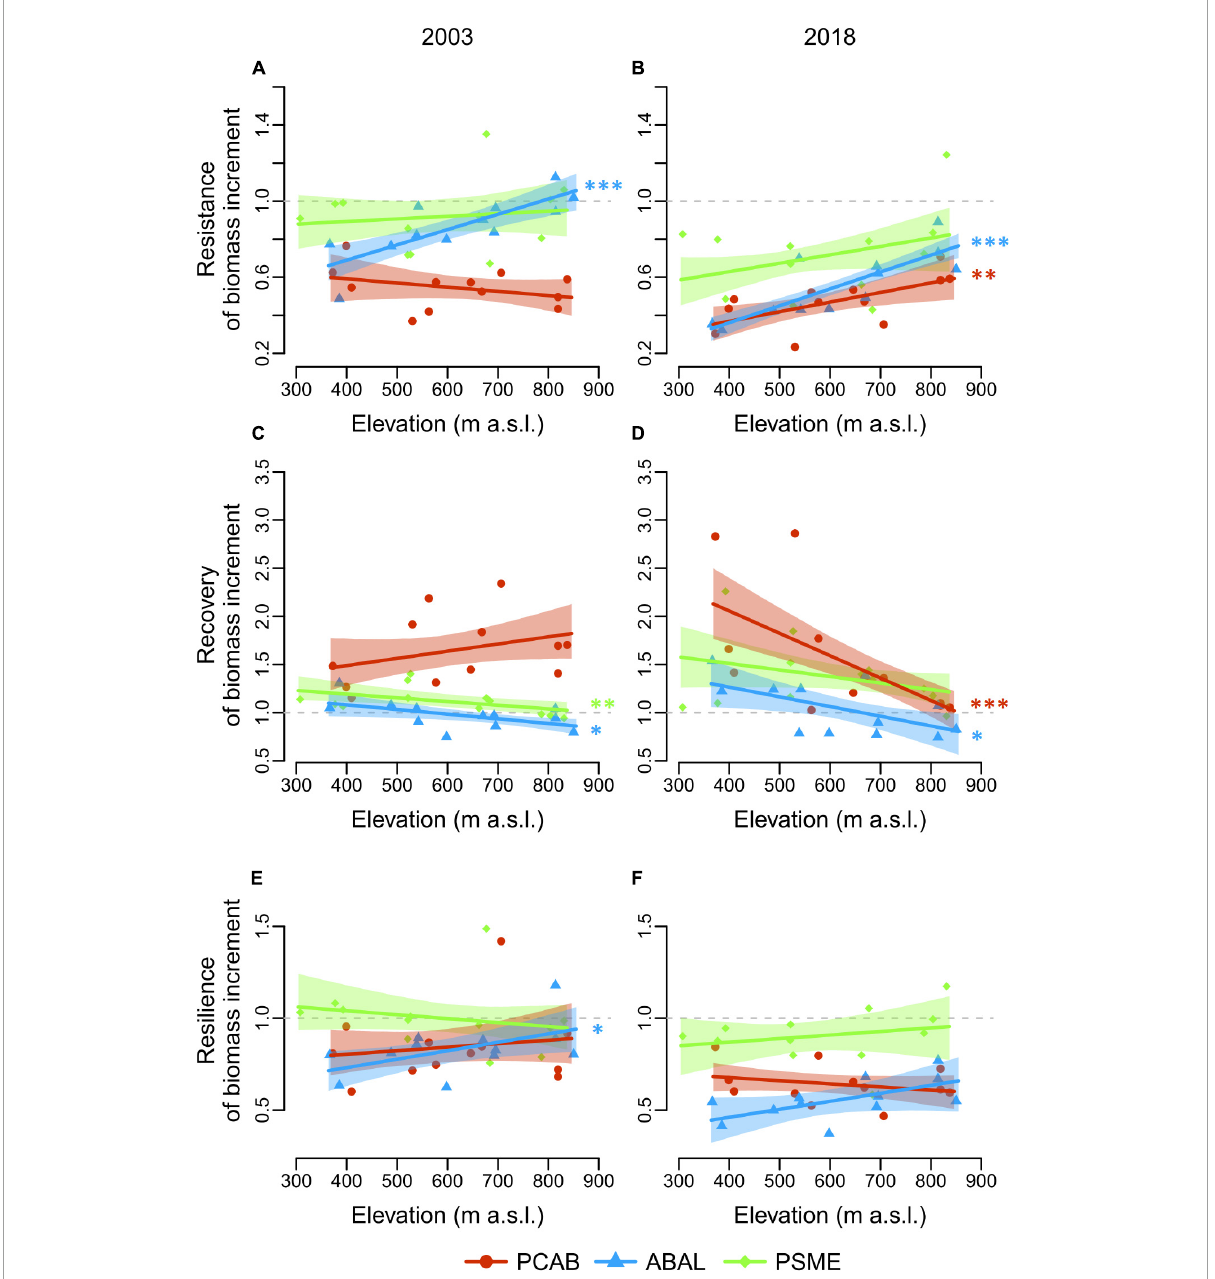
FIGURE6 Resistance (A,B) , recovery (C,D) and resilience (E,F) indices of stem radial biomass increment of Norway spruce (PCAB), silver fir (ABAL) and Douglas fir (PSME) in response to elevation for the two extreme drought events of the years 2003 (left) and 2018 (right). Transparent ribbons indicate bootstrapped 95 % confidence intervals of predictions of linear mixed-effects models based on 10,000 replications. For illustration, data points were averaged on the stand level. Asterisks on the right side of the panels indicate if slopes of the regression lines are significantly different from zero based on bootstrapped confidence intervals: 95% “*”, 99% “**”, 99.9% “***”. Marginal R 2 and conditional R 2 of the linear mixed-effects models are listed in Supplementary Table 4